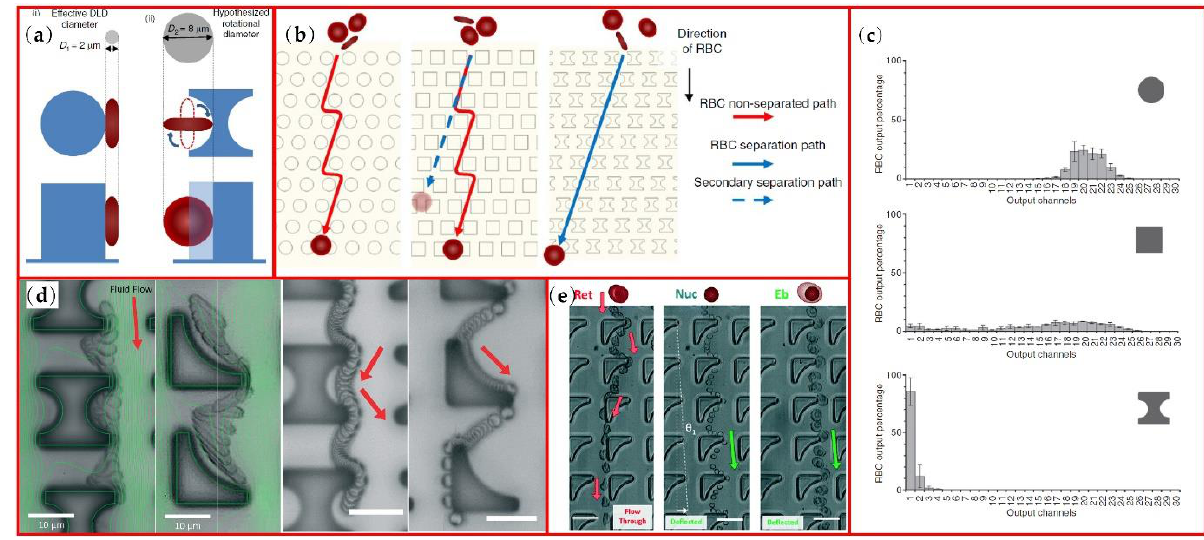
Figure 6. Non-spherical particles focusing in DLD microchannels: ( a ) difference of particle rotation in round and I-shaped pillars DLD; ( b ) projected paths of RBCs passing through round, square and I-shaped pillars; ( c ) results of the RBC separation for round, square and I-shaped pillars; ( d ) RBCs and spherical beads separation movement tracking in I-shaped and L-shaped pillars; ( e ) reticulocyte separation from expelled nuclei and nucleated erythroblasts in inverse-L pillar arrays. Figures ( a – c ) are reprinted with permission from [88], Copyright 2013 Springer Nature). Figure ( d ) is reprinted with permission from [89], Copyright 2014 RSC Publishing. Figure ( e ) reprinted with